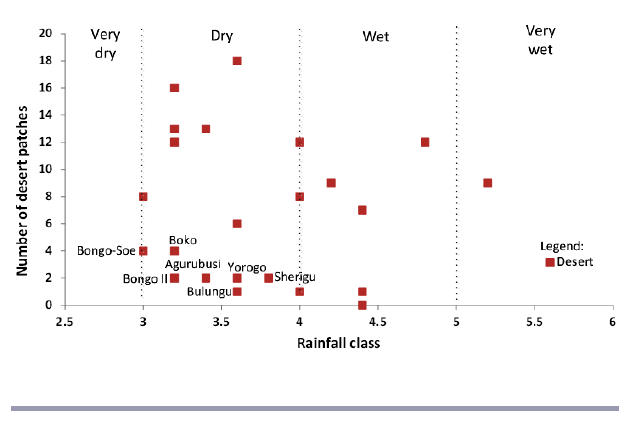
Fig. 6 . Prevalence of desertification among grazing game trials in Ghana (N = 23).